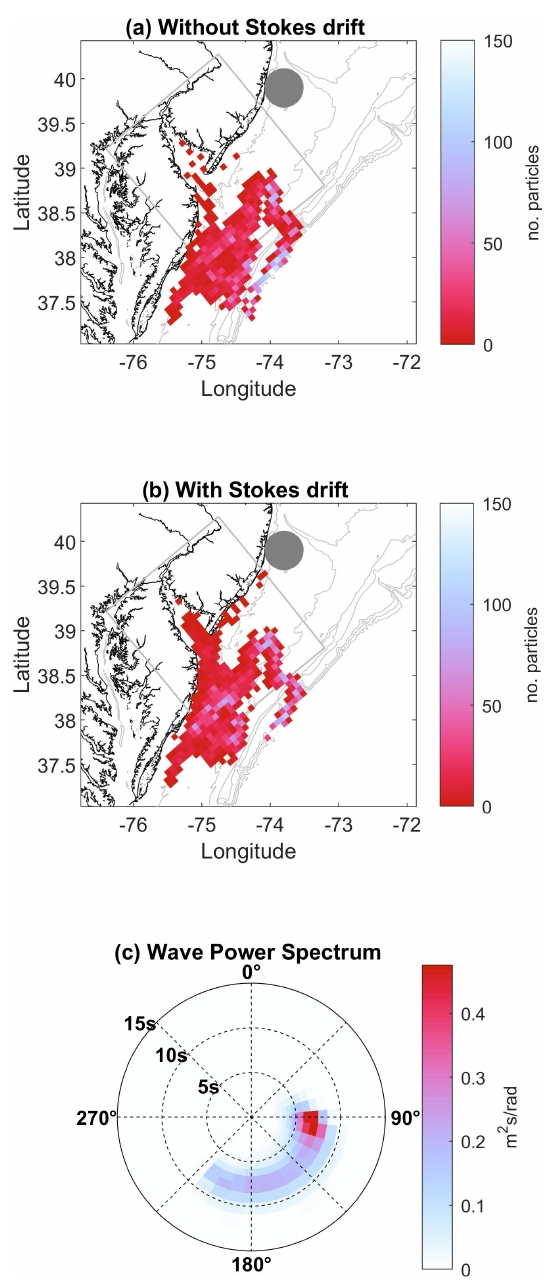
Figure 7. ROMSPath simulations showing particle distributions af- ter 30d (a) without Stokes drift (case J), and (b) with Stokes drift (case K). The mean directional wave spectrum (c) is shown from the SWAN model output in the SnailDel domain over the 30d re- lease period (direction is the direction waves come from). Particle initial locations are designated by the dark grey circle. In this exam- ple, more particles enter the bay when Stokes drift is included than when it is omitted, consistent with waves entering the domain from the